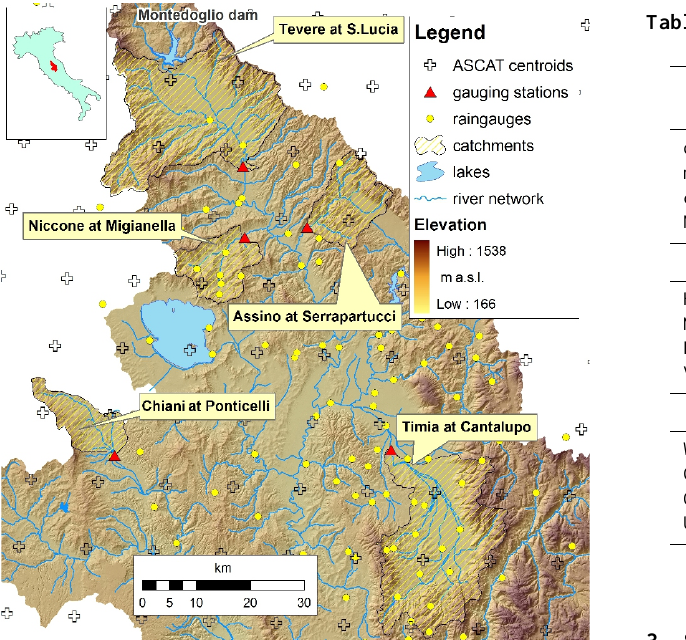
Fig. 1. – Morphology and hydrometeorological network of the study area (Upper Tiber river basin). The five subcatchments an- alyzed in the study along with the location of the ASCAT pixel cen- troids are also shown.